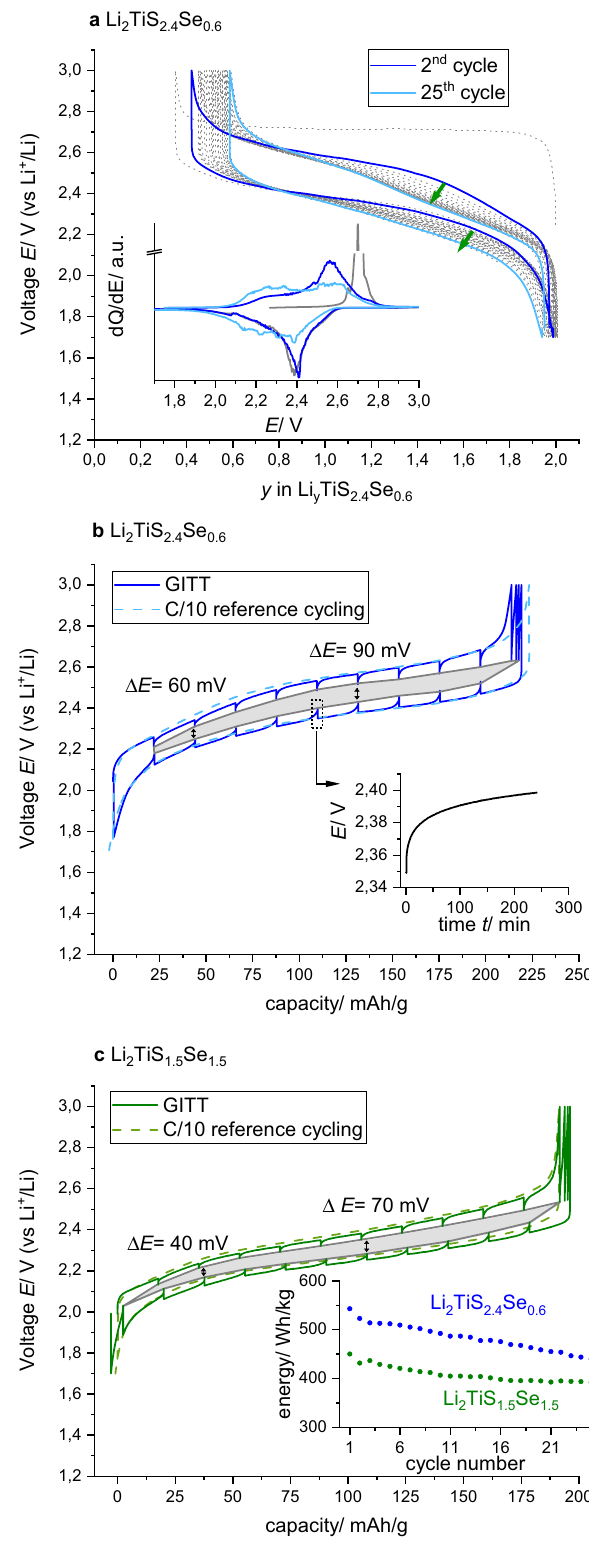
Fig. 2 Electrochemistry of Li 2 TiS 2.4 Se 0.6 and Li 2 TiS 1.5 Se 1.5 . a Voltage trace of Li 2 TiS 2.4 Se 0.6 during 25 cycles (discharge-voltage drops from 2.33 to 2.25 V), inset: d Q /d E vs E for the 1st, 2nd and 25th cycle. b GITT experiment of Li 2 TiS 2.4 Se 0.6 . c GITT experiment of Li 2 TiS 2.4 Se 0.6 , inset: comparison of discharge energy of Li 2 TiS 2.4 Se 0.6 with Li 2 TiS 1.5 Se 1.5 during the fi rst 25